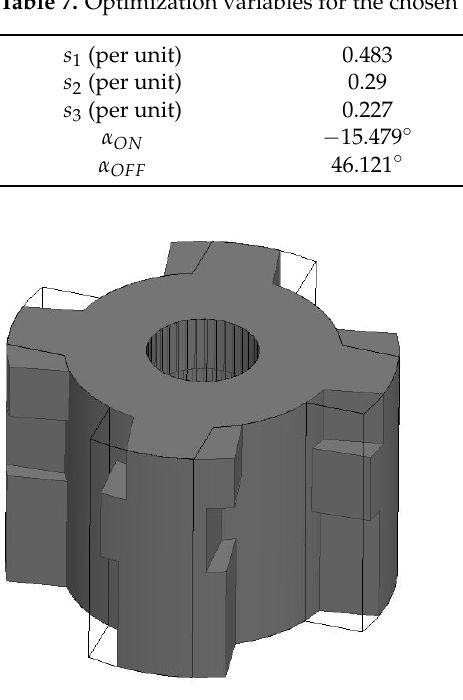
Figure 15. Optimized ASR-SRM design for I = 260 A and ω = 12,000 rpm.